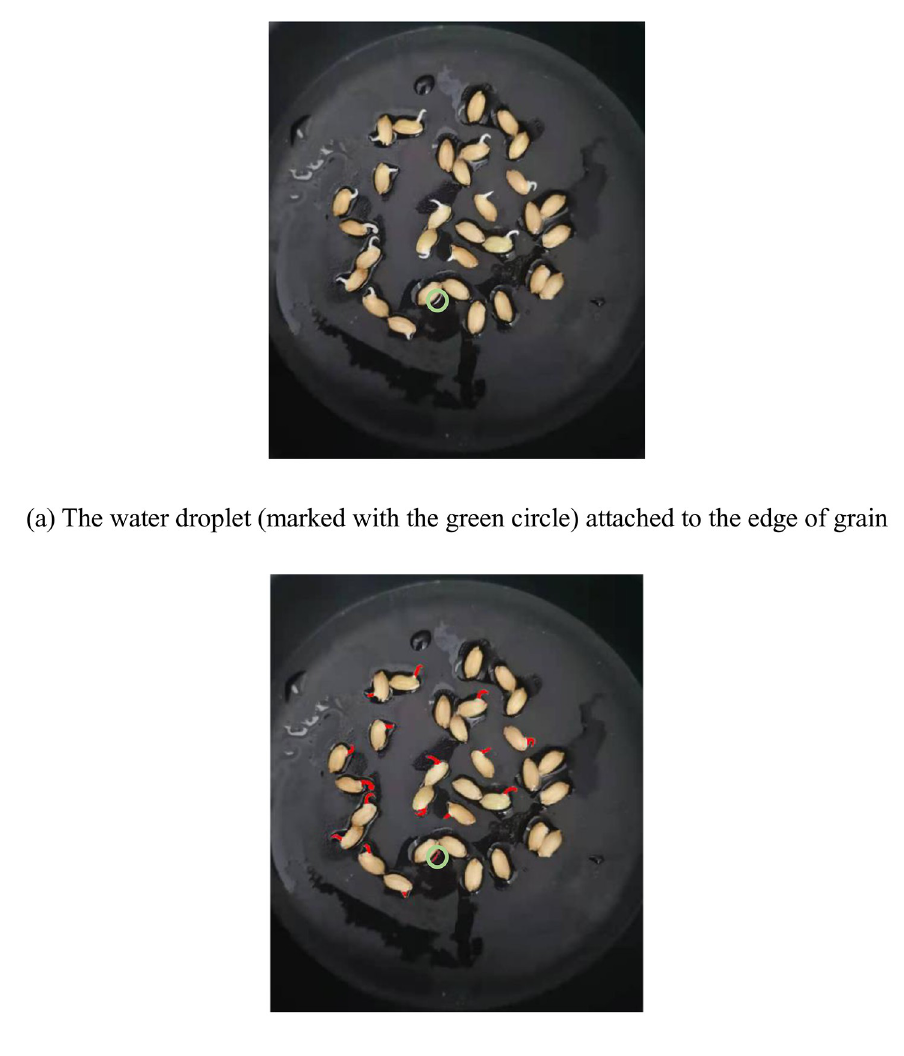
Fig 13. An incorrect